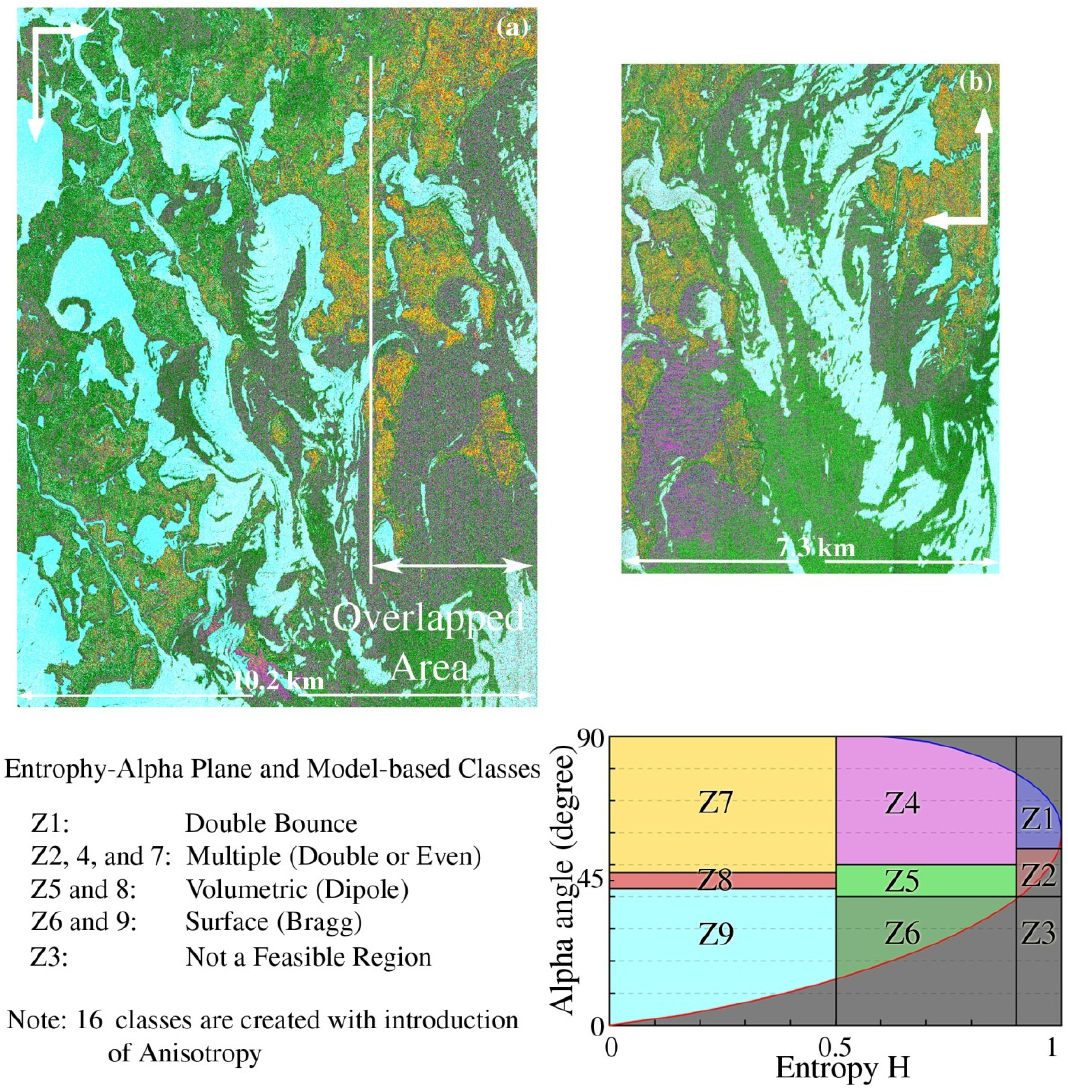
Figure 14. The CP decomposition of the 2010 MLC data of the (a) Barataria Bay (BB) and (b) Grand Isle (GI) flight lines, with the overlapping region common to the BB, GI, and MRD lines indicated. MRD, BB, and GI renditions used the same color reference